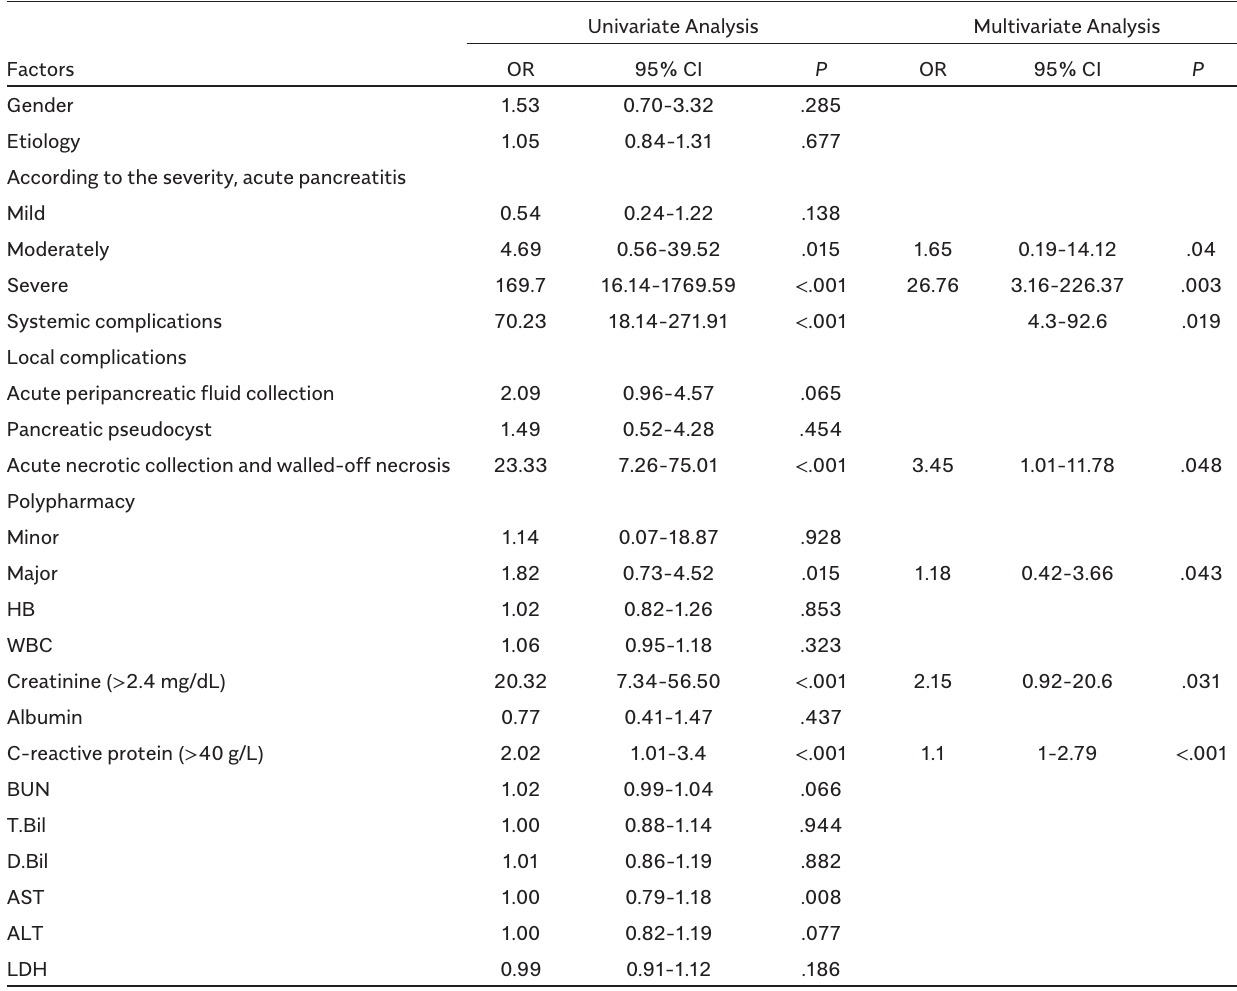
Univariate Analysis Multivariate Analysis